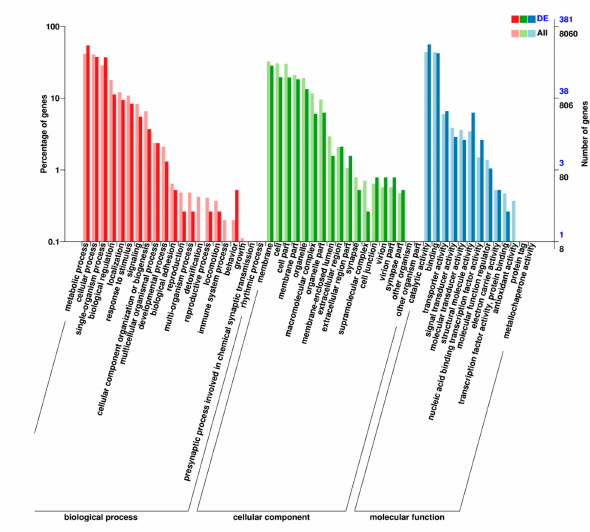
Figure 7. Gene Ontology (GO) statistical histogram of differentially expressed genes.